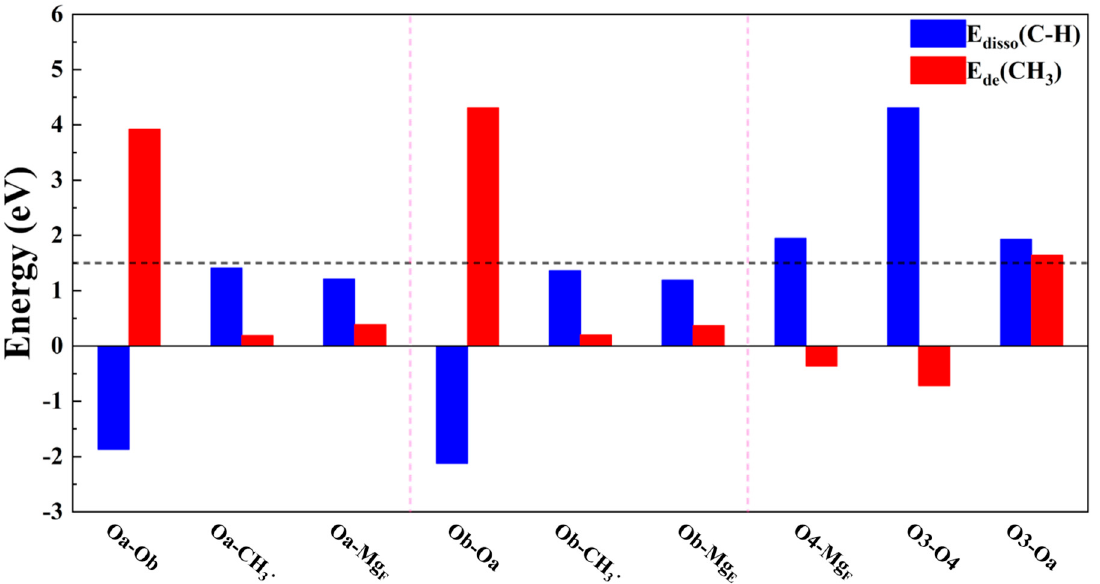
Figure 2. The dissociation energy (E disso ) and desorption energy (E de ) of methane at various sites on Mo-doped MgO(100). The labels associated with binding sites are indicated in Figure 1 dopant effects in OCM but also provide insight into the future design of the doped metal oxide catalyst.